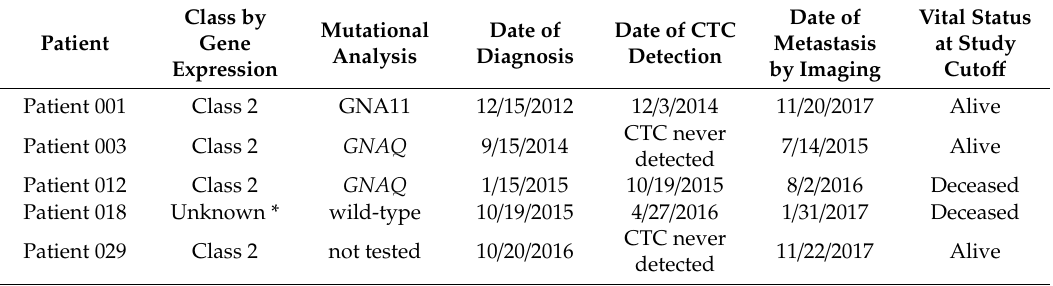
Table 3. Characteristics of patients who developed metastasis in early-stage uveal melanoma